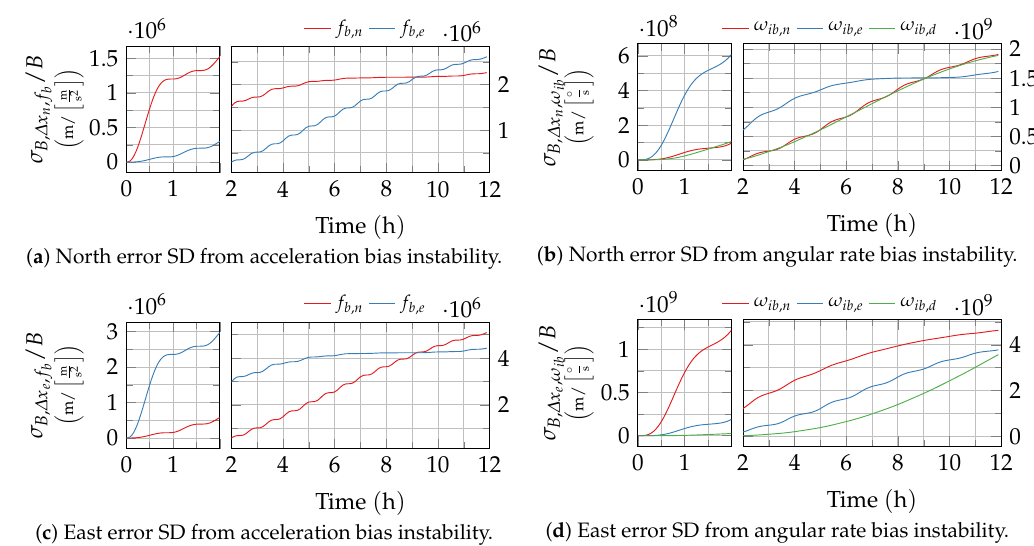
( c ) East error SD from acceleration bias instability. ( d ) East error SD from angular rate bias instability. Figure 9. Position error growth from bias instability with T 0 = 100s. The time axis of the plots is split to provide a better resolution of the short-term